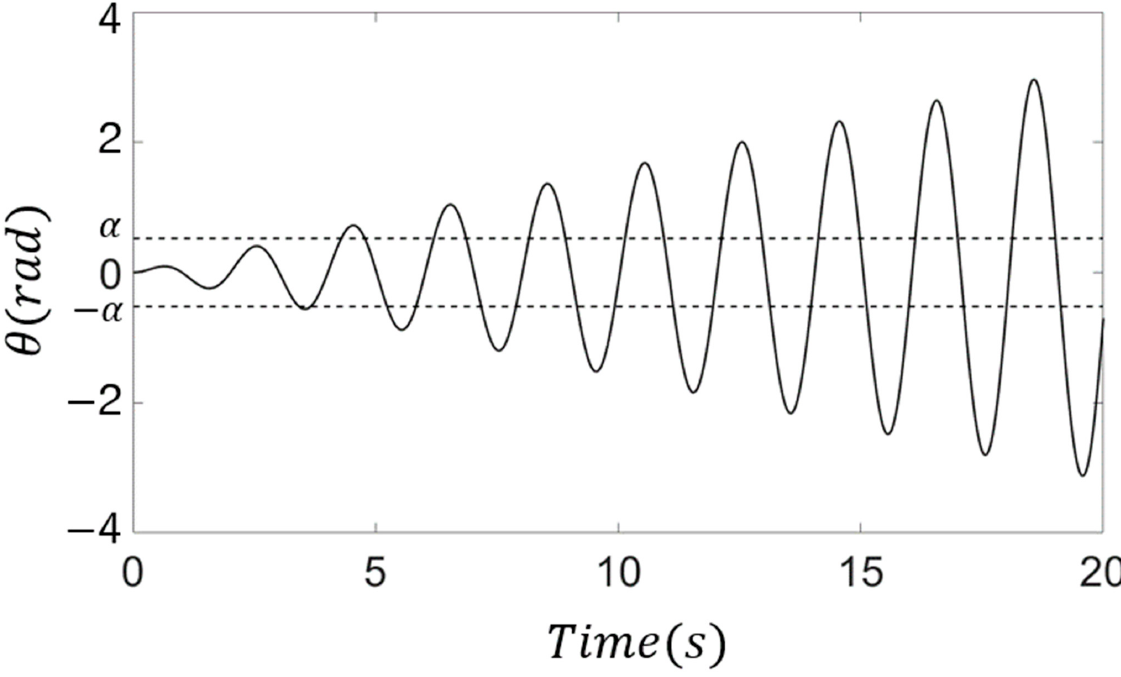
Figure 2. Angular displacement of the pendulum θ